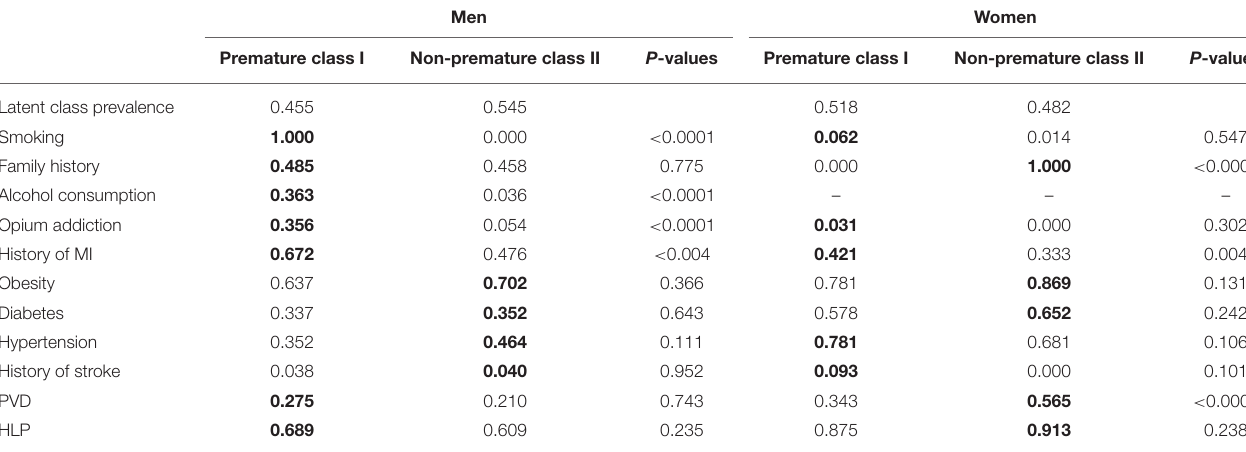
TABLE 3 | The latent class analysis and the calculated model for the prevalence of the indicators among men and